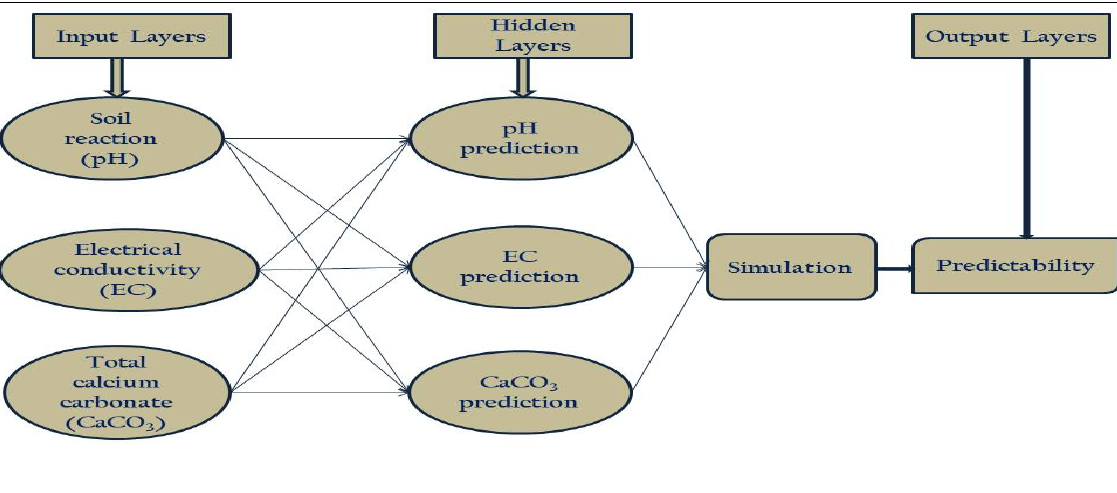
Figure 2. Neural Network Approach fl owchart.